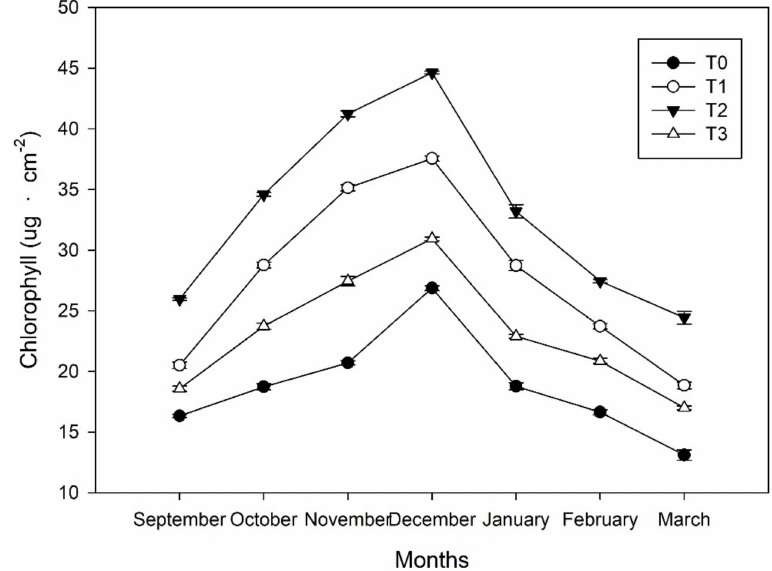
Figure 4. Dynamics of leaf chlorophyll (ug · cm − 2 ) in Magnolia wufengensis under ethephon (ETH)